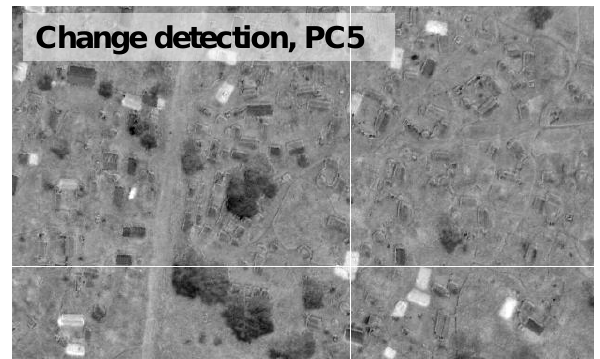
Figure 10. Monitoring settlement dynamics between October 2004 and February 2006 in a migrant village, Kpawa, in Central Benin, West-Africa, with a parachute